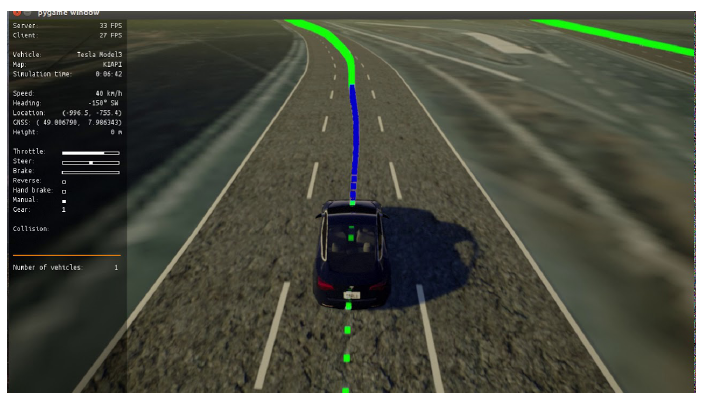
Figure 11. Carla simulator